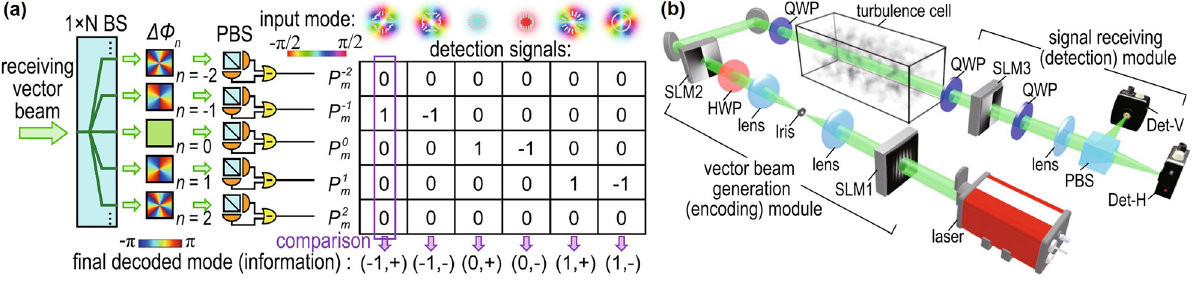
Figure 26: High-dimensional free-space optical communications using turbulence-resilient vector beams. (a) The principle of signal detection and (b) schematics of the experiment of high-dimensional spatial polarization differential phase shift keying (SPDPSK) [135]. Reprint permission obtained from